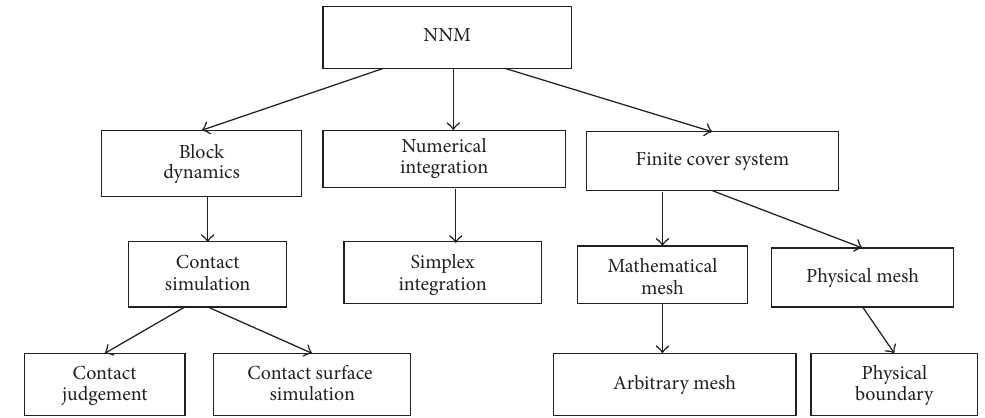
Figure 1: Basic structure of the